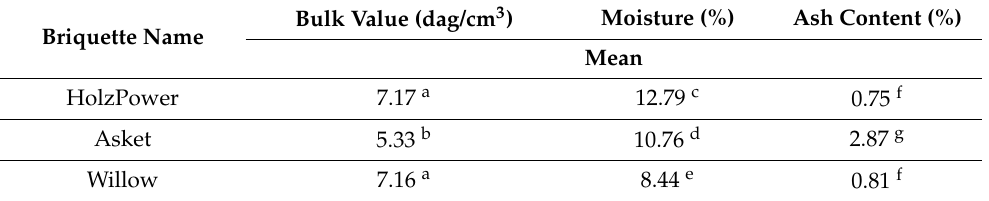
Table 3. Characteristics of the effect of the material type on bulk density for the briquette analysed.